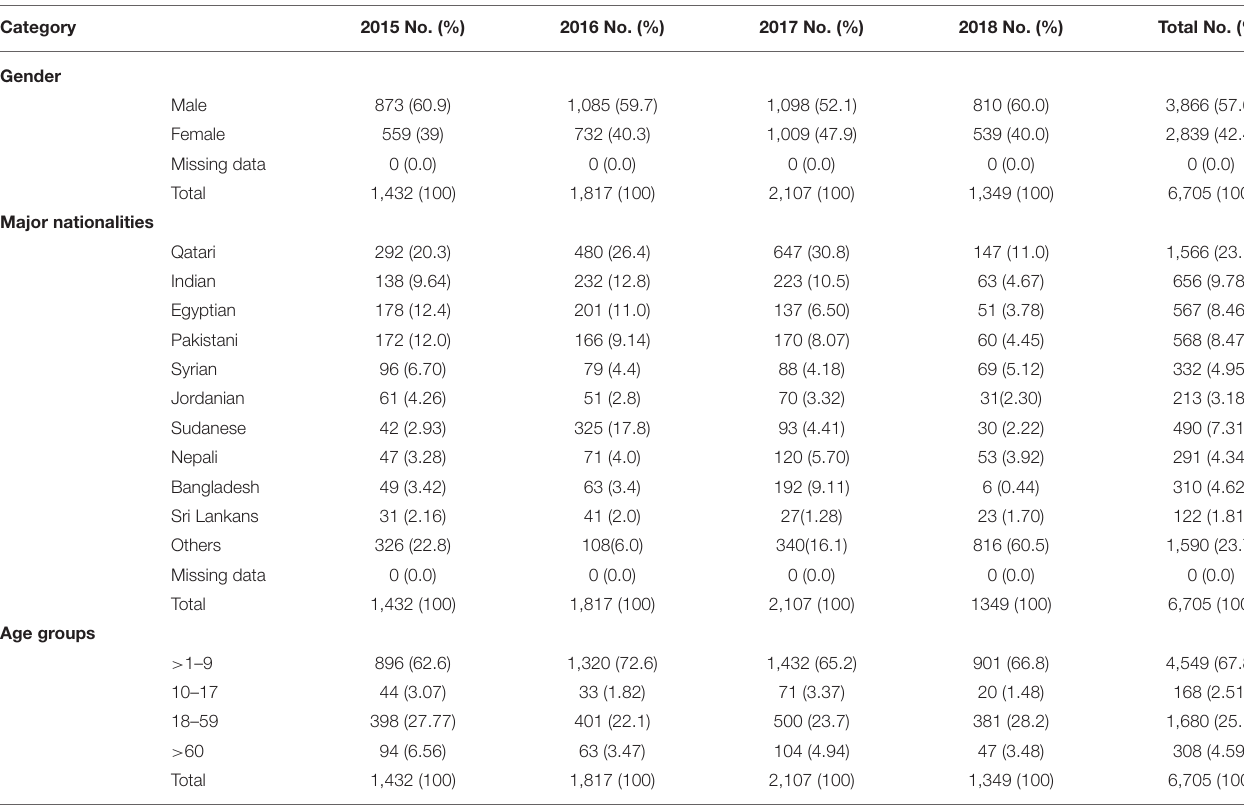
TABLE 1 | Demographic characteristics of the study population.